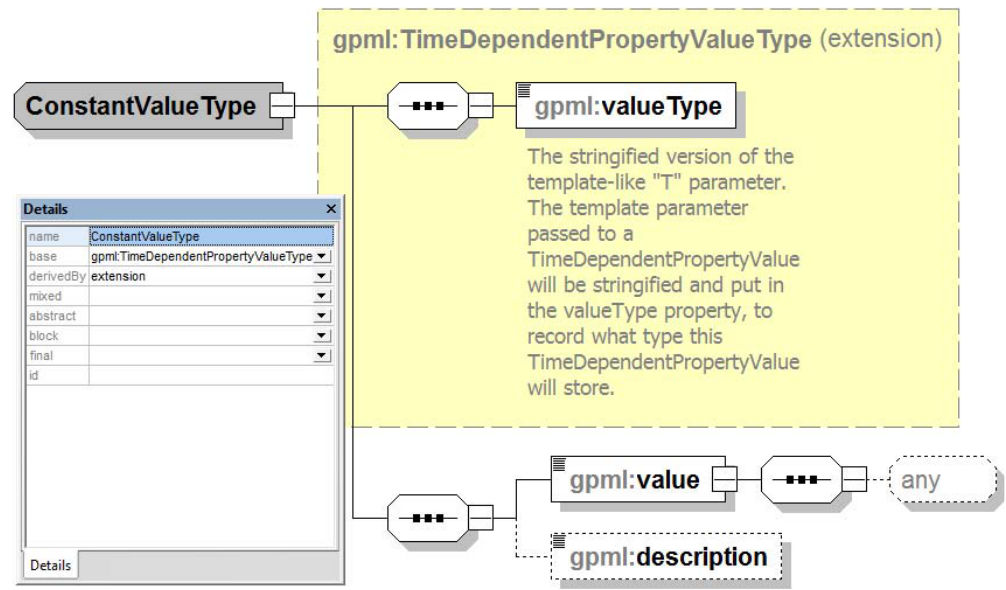
Fig. 13. The constant property value schema diagram in